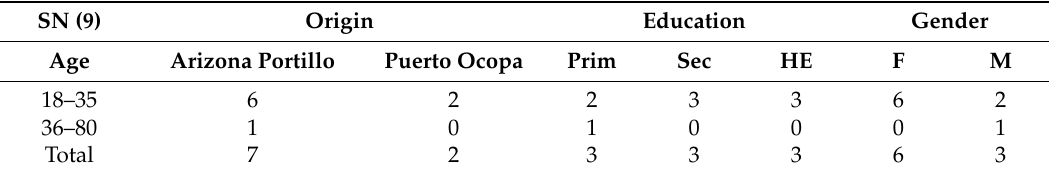
Table 1. Spanish native speakers (SN) by age, location, education, and